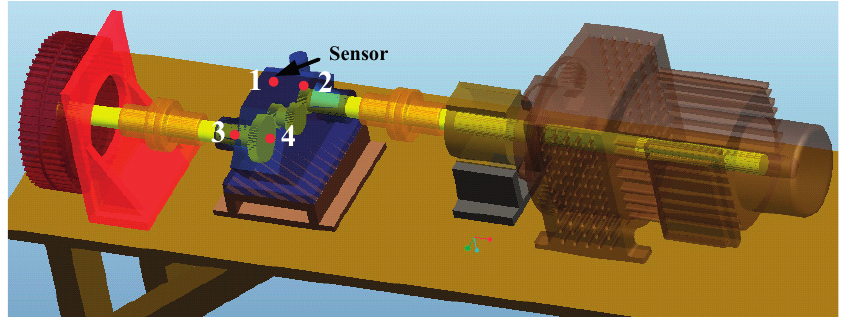
Figure 15. Three dimensional graph of the gearbox